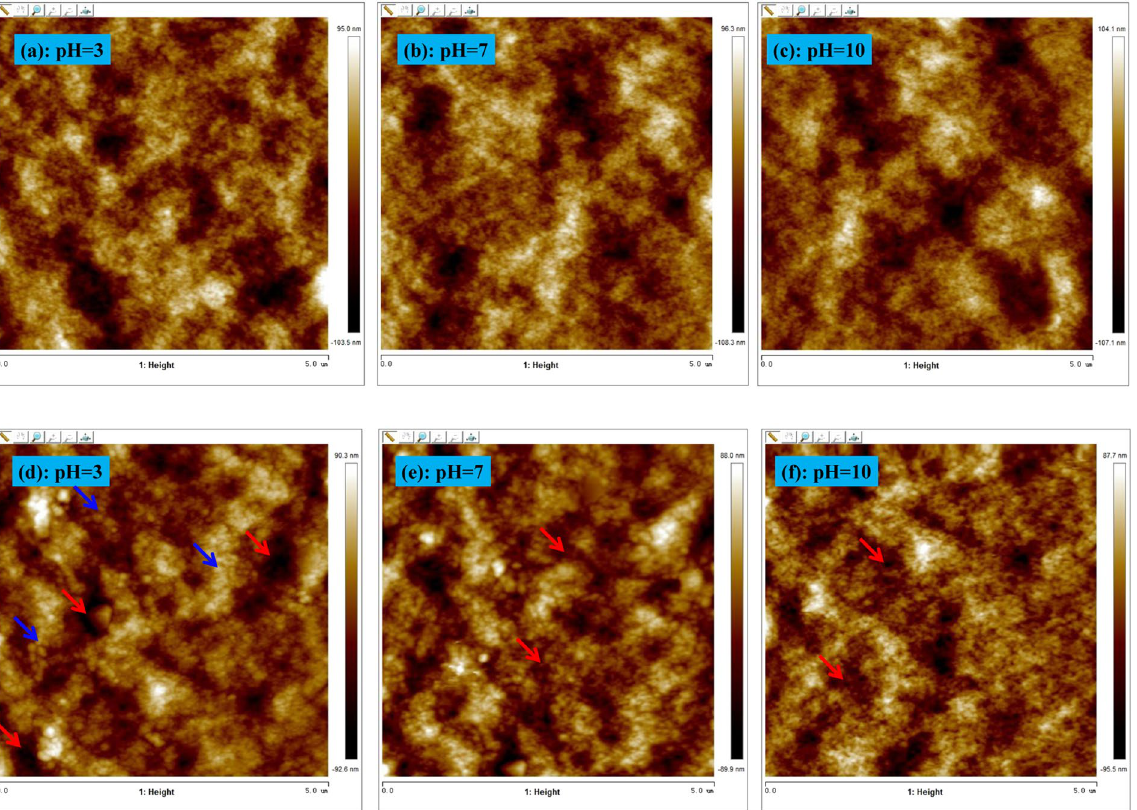
Figure 8. In situ surface topography variations of the control and grafted membranes under different pH values observed by AFM: ( a – c ) the control membrane under pH = 3, 7, 10, respectively; ( d – f ) the grafted membrane under pH = 3, 7, 10, respectively.